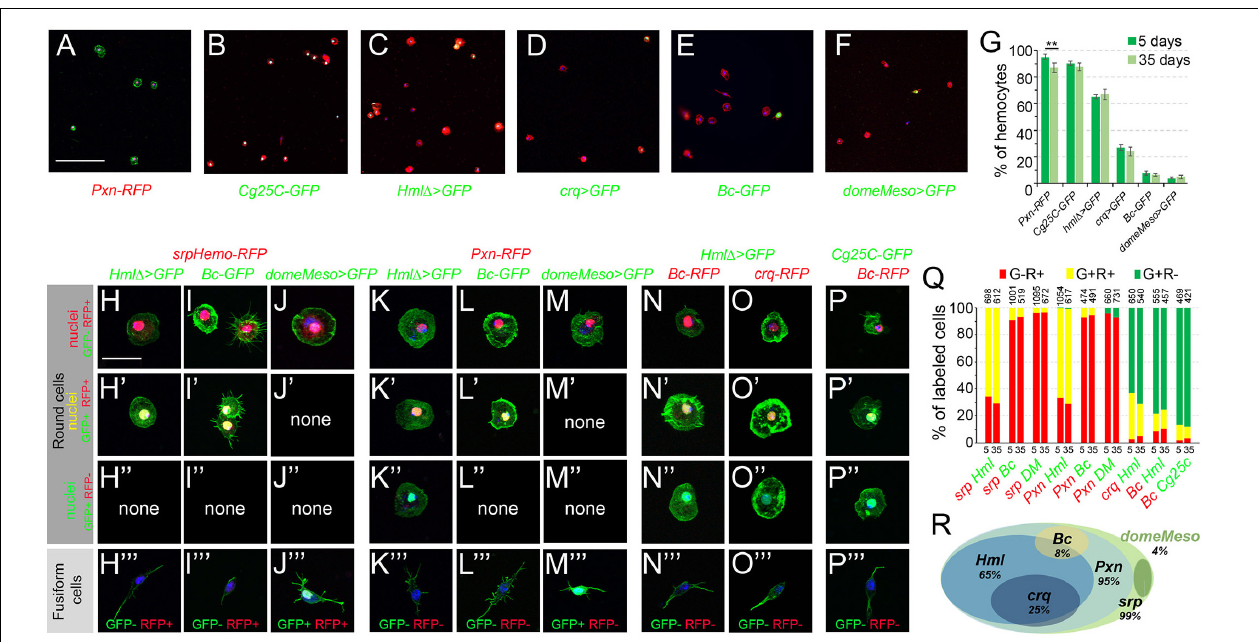
FIGURE 3 | Analysis of blood cell transgenic markers in adult bleeds. (A–F) Confocal views showing representative bleeds from 5-day-old flies carrying the following transgenes: Pxn-RedStinger ( A , Pxn-RFP ), Cg25C-GFP (B) , Hml (cid:49) -GAL4,UAS-2xEYFP ( C , Hml (cid:49)> GFP ), crq-GAL4,UAS-2xEYFP ( D , crq > GFP ), BcF2-GFP ( E , Bc-GFP ), domeMeso-GAL4,UAS-2xEYFP ( F , domeMeso > GFP ). Cells were counterstained with phalloidin ( A : green, B–F : red) and DAPI (blue). Scale bar 200 µ m. (G) Quantifications of blood cell proportions expressing the indicated transgenes in 5- or 35-day-old flies. Means and standard deviations from four to six independent experiments are represented. From 200 to 600 DAPI + cells were scored in each experiment. ** p < 0.01 (Student’s t -test). (H–P) High magnification views showing the different types of blood cells observed in bleeds from 5-day-old flies carrying the following combination of transgenes: srpHemo-His2A-RFP, Hml (cid:49) -GAL4,UAS-2xEYFP (H) , srpHemo-His2A-RFP, BcF2-GFP (I) , srpHemo-His2A-RFP, domeMeso-GAL4,UAS-2xEYFP (J) , Pxn-RedStinger, Hml (cid:49) -GAL4,UAS-2xEYFP (K) , Pxn-RedStinger, BcF2-GFP (L) , Pxn-RedStinger, domeMeso-GAL4,UAS-2xEYFP (M) , Hml (cid:49) -GAL4,UAS-2xEYFP, BcF6-mCherry (N) , Hml (cid:49) -GAL4,UAS-2xEYFP, crq-RedStinger (O) , Cg25C-GFP, BcF6-mCherry (P) . GFP and RFP signals are nuclear; cells were counterstained with DAPI (blue) and phalloidin (green). The top three panels show round cells expressing or not RFP and/or GFP; the bottom panels (”’) show fusiform cells together with their GFP/RFP